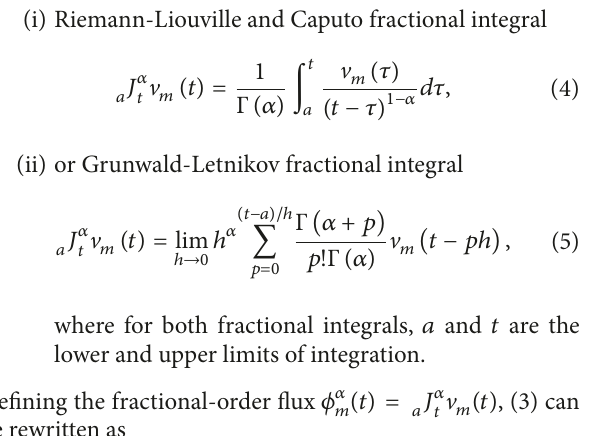
pinched hysteresis loop on the voltage-current plane, respec- tively [25], and 𝑎 𝐽 𝛼 𝑡 denotes the fractional-order integral operator